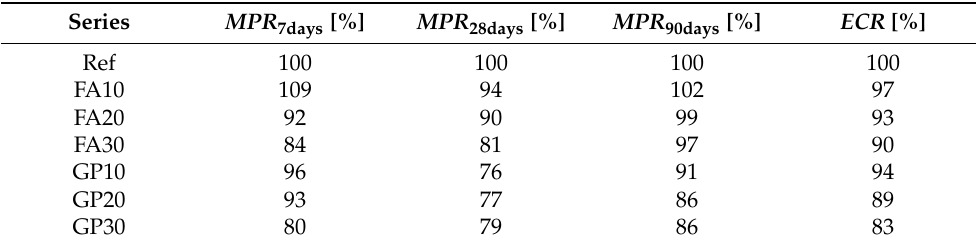
Table 4. Mechanical performance ratio ( MPR ) and effective cost ratio ( ECR ) parameters with regards to the cementitious mortar series.